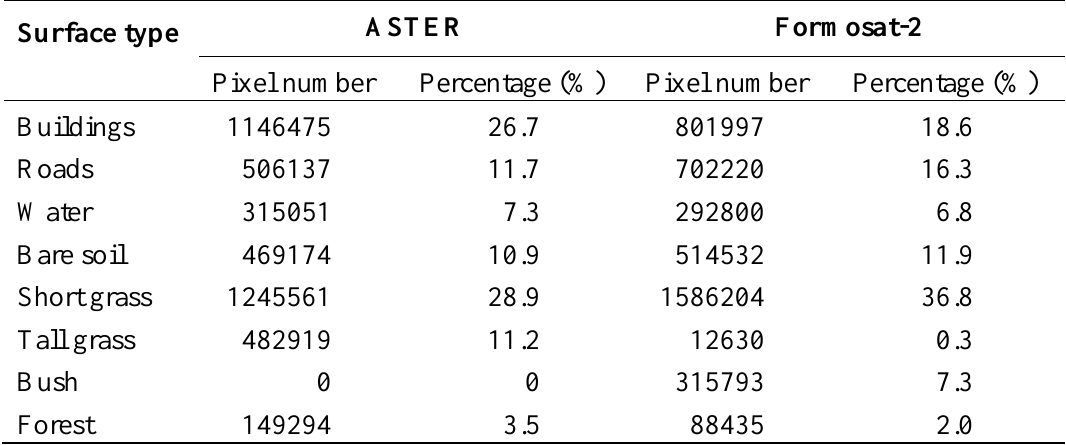
Table 3. Pixel numbers and percentages for each surface type category derived from ASTER and Formosat-2